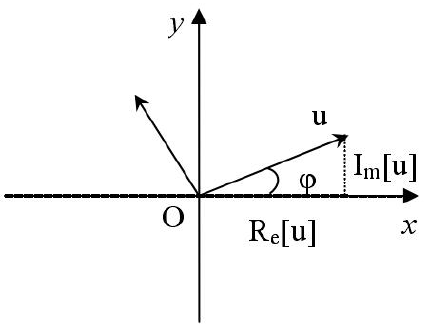
Figure 16. Particle velocity decomposition of a plane acoustic wave.